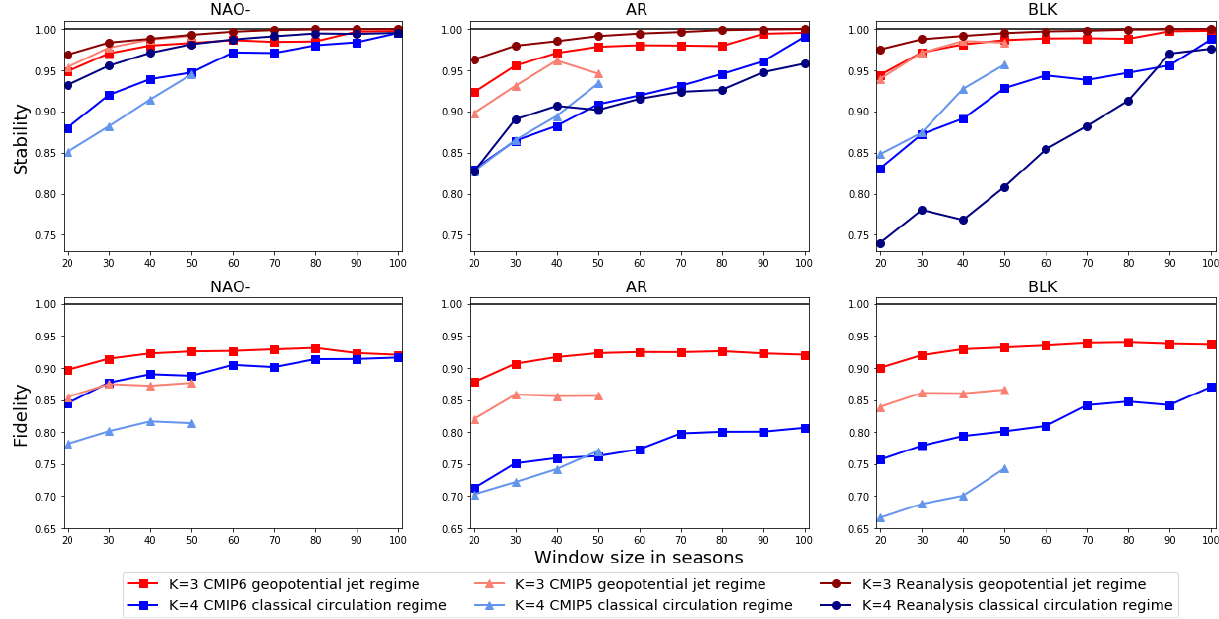
Figure 6. Regime stability and fidelity as a function of subsample window size. Ensemble mean values are shown for each atmospheric regime pattern as identified using both four classical circulation regimes and three geopotential-jet regimes.